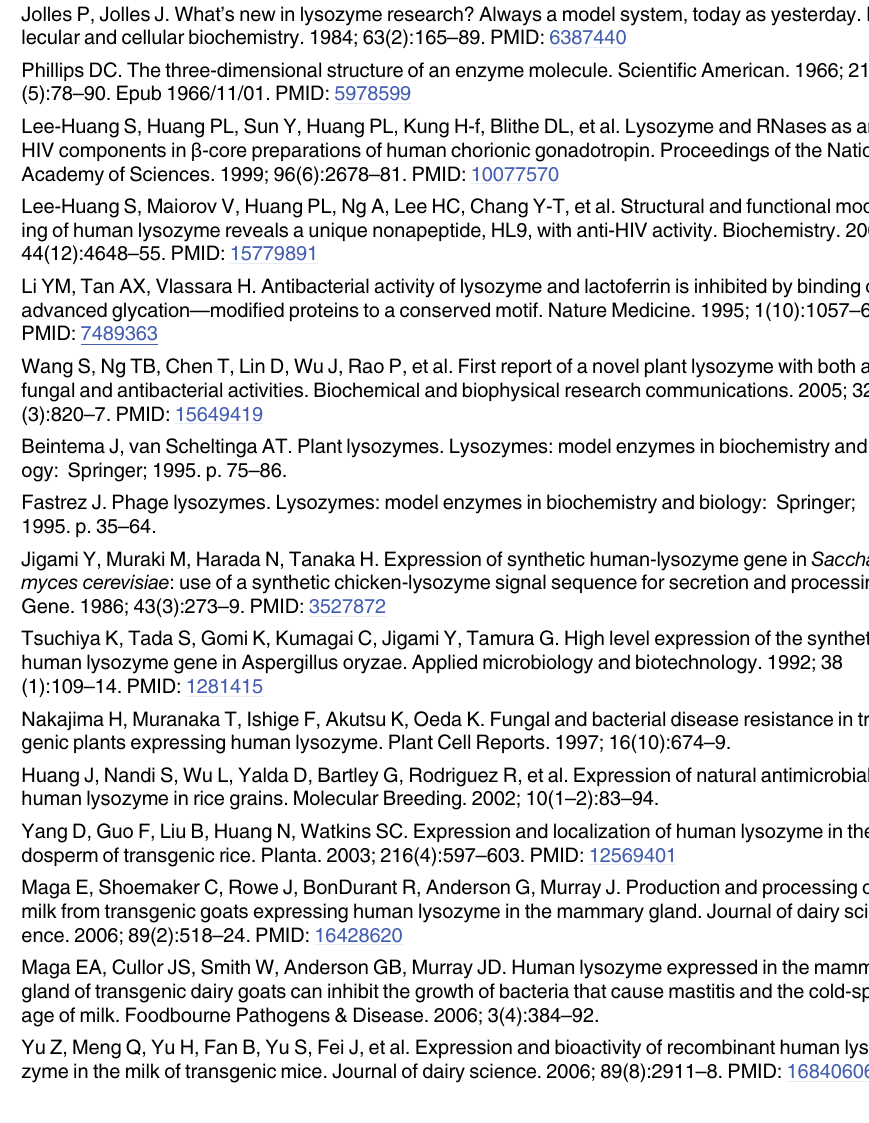
S1 Table. Primer